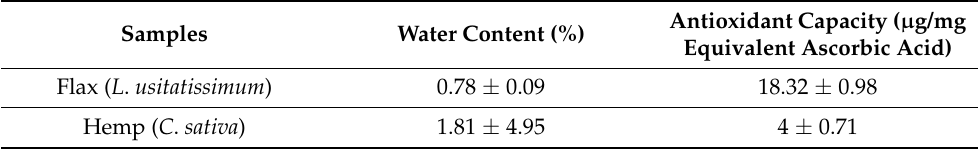
Table 2. The content of water and antioxidant capacity in tested